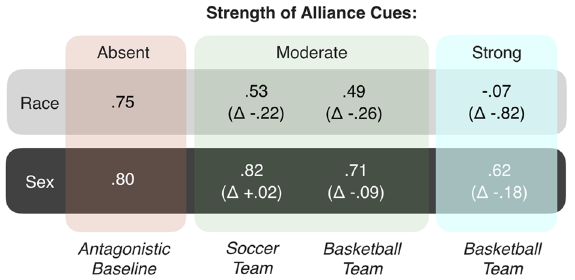
Figure 3. Categorization effect sizes ( r ) for race and sex across the baseline and alliance conditions, with changes in categorization (Δ) denoting the difference in magnitude compared to baseline.